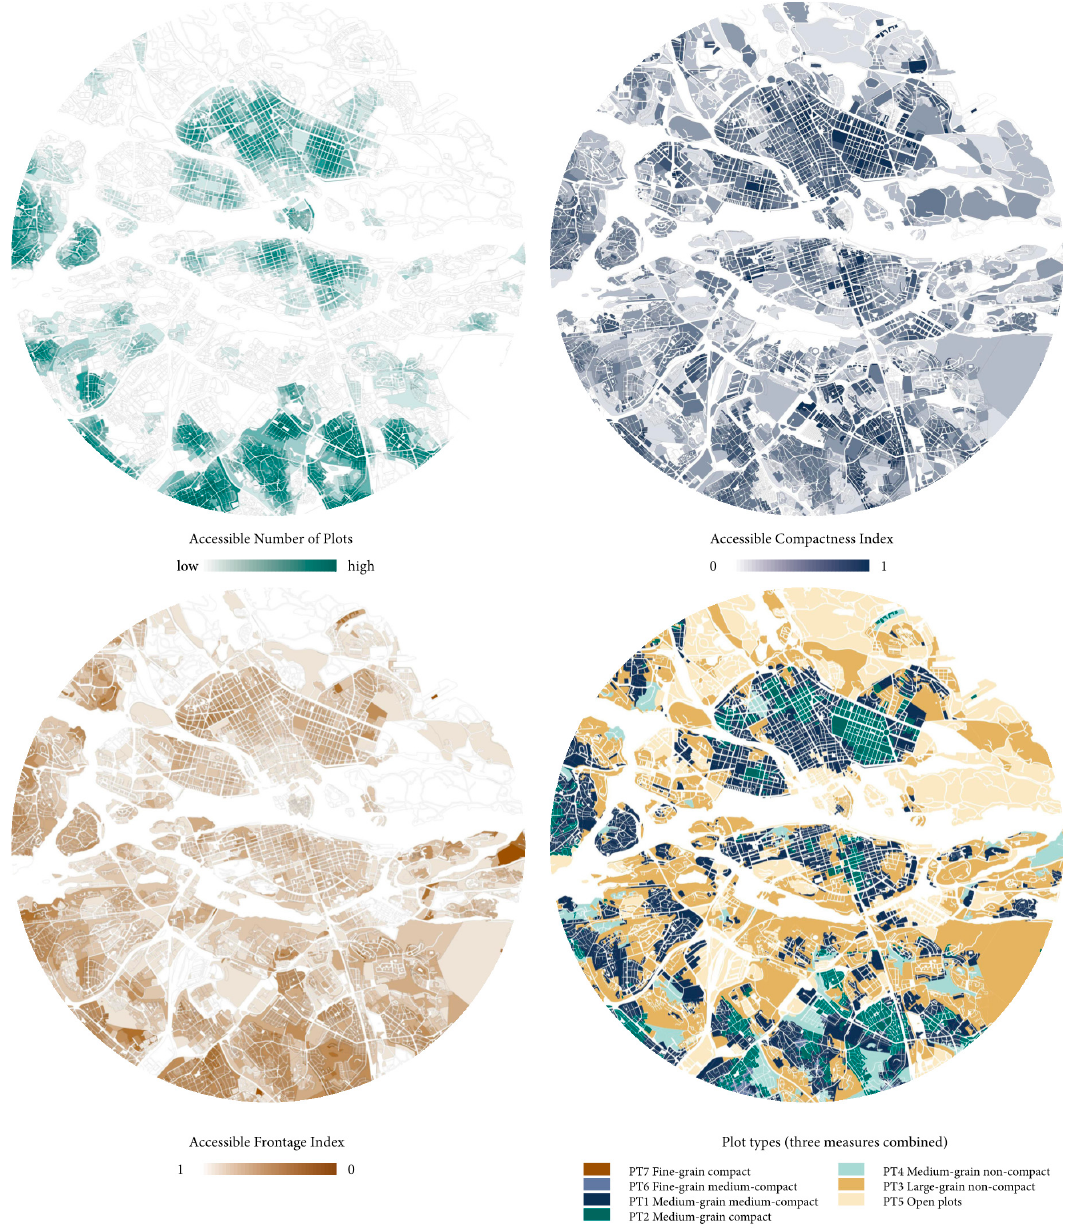
Figure A4. Stockholm. Overview of three plot measures (accessible number of plots, accessible compactness index, accessible frontage index) and seven plot types that combine these three measures.